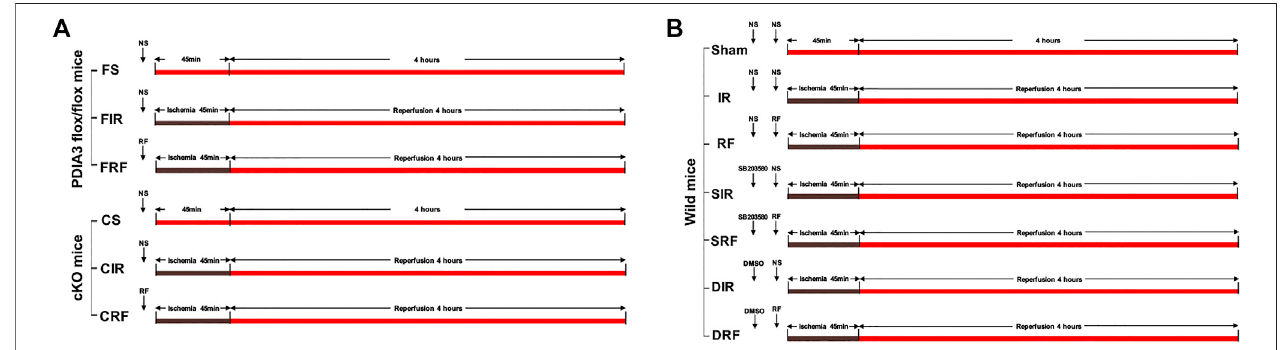
FIGURE 1 | Experimental protocols. (A) Experiment 1. (B) Experiment 2. NS = normal saline; RF = remifentanil; SB203580, the selective p38MAPK inhibitor; DMSO, the solvent of